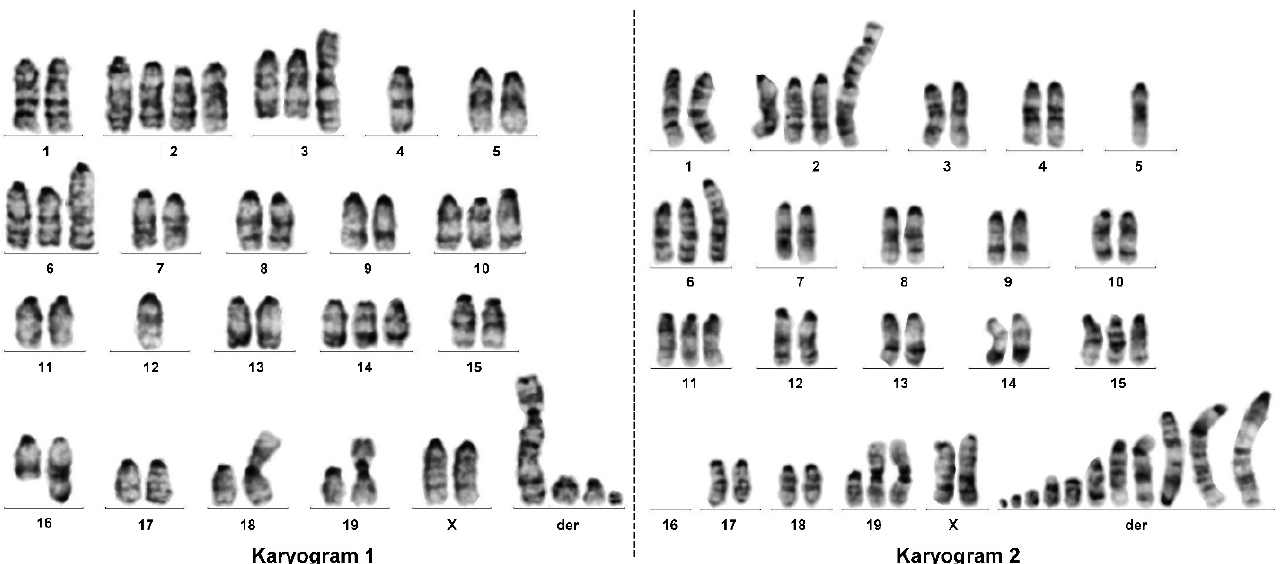
Figure 6. REEAD analysis for HIV, MLV, and MMTV integrases. The REEAD analysis for MMTV integrase was performed in supernatant of cultured GRX cells. As a positive control, purified integrase was analyzed in parallel. As negative controls, integrase activity was measured in buffer alone or in basal medium. As additional controls, tests that contained the integrase inhibitor raltegravir were carried out in parallel. Error bars represent standard deviations calculated from the results of three independent experiments.